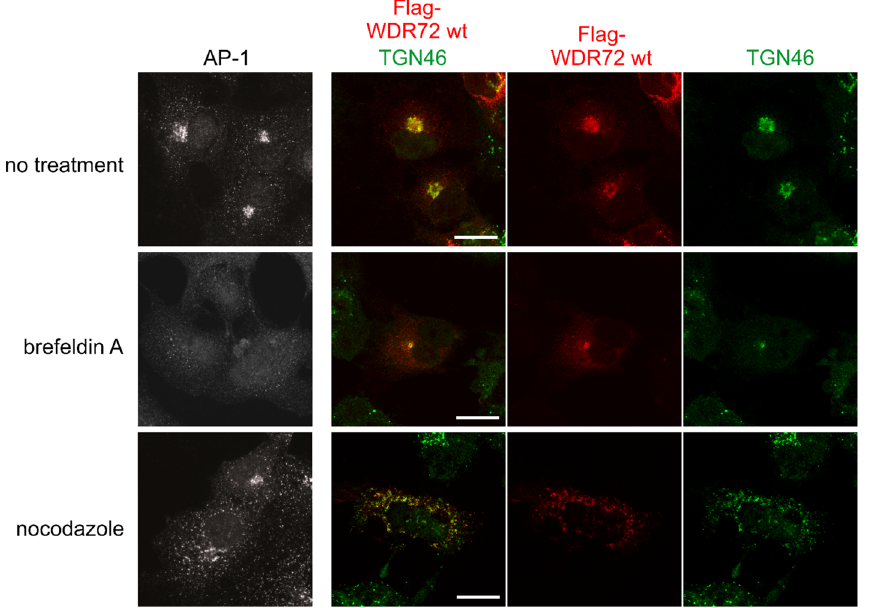
Figure 4. WDR72 localizes at Golgi. COS-7 cells were transiently transfected with Flag-tagged WDR72 wild- type (wt) and the immunolocalization of WDR72 was investigated using anti-Flag antibody together with the endogenous Golgi marker TGN46. Brefeldin A and nocodazole were used to change the morphology of the Golgi whether these drugs affect WDR72 localization. The transfected cells with Flag-WDR72 wt showed the punctate patterns with perinuclear accumulation, co-immunostained with anti-TGN46 antibody, demonstrating that WDR72 localizes at the Golgi. Scale bar represents 25